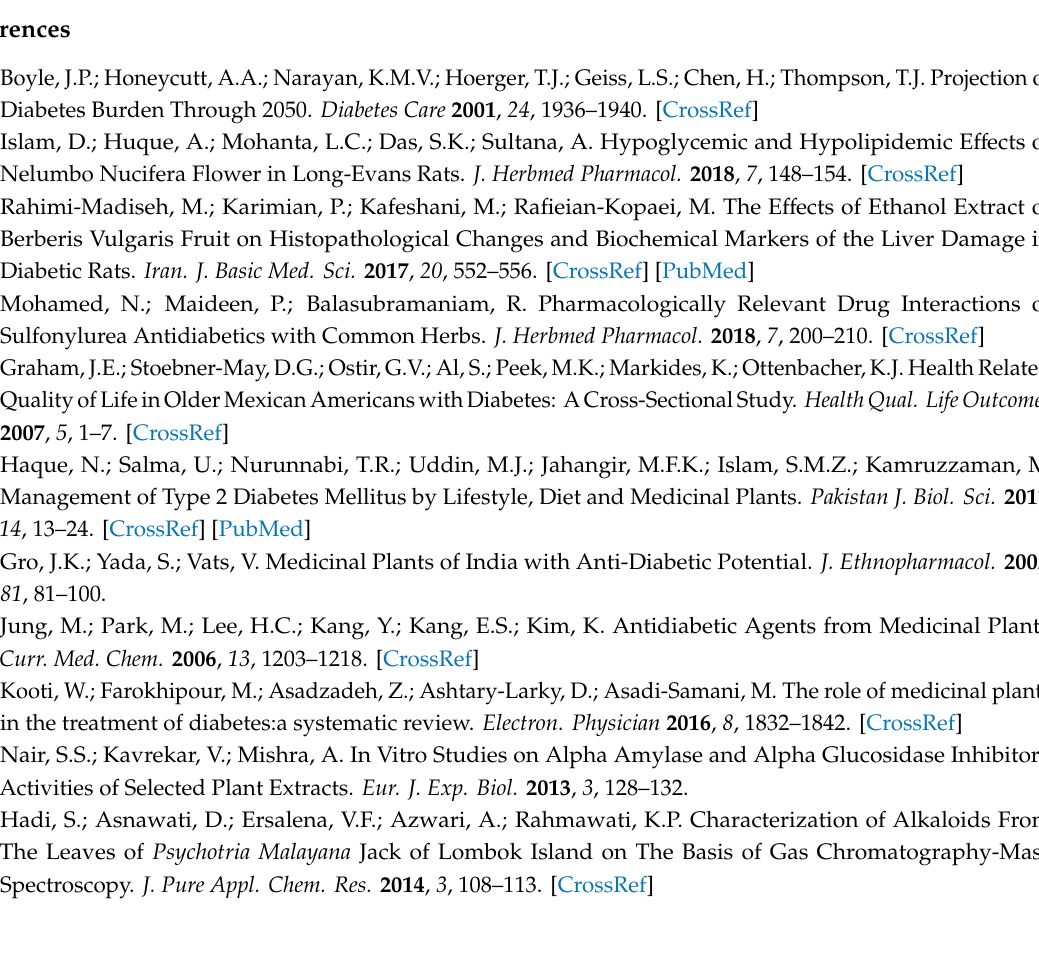
Supplementary Materials: The following is available online, Figure S1: Fragmentation pathway of three identified